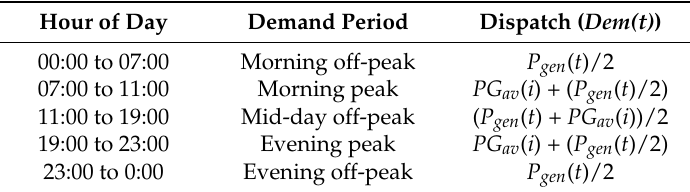
Table 1. Dispatch curve